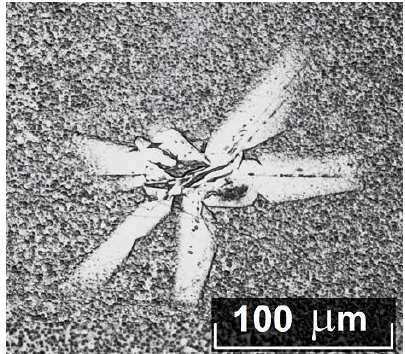
Figure 12. Separation of the second phase with coherent boundaries in the crystal LiNbO 3 :Zn ([Zn] = 4.77 mol.% in the crystal). Z-cut.